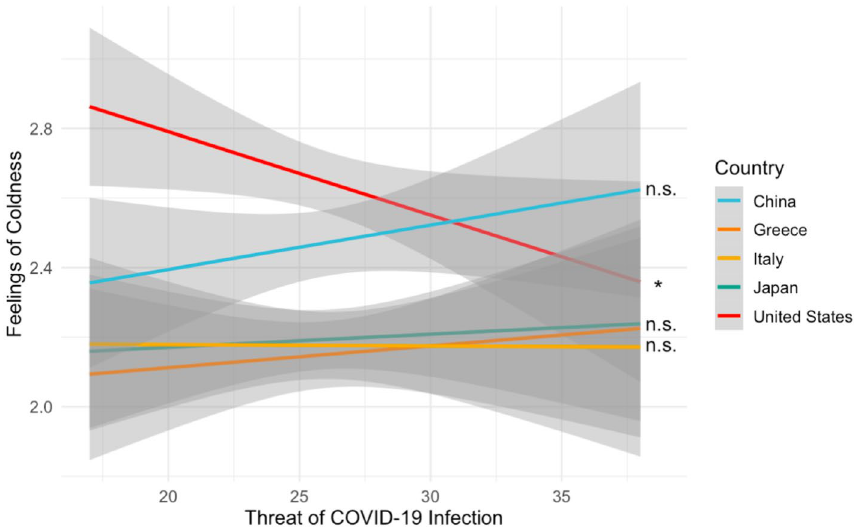
Figure 3. Perceived individual risk is associated with less coldness toward American nationals and is unrelated to warmth felt toward all other groups